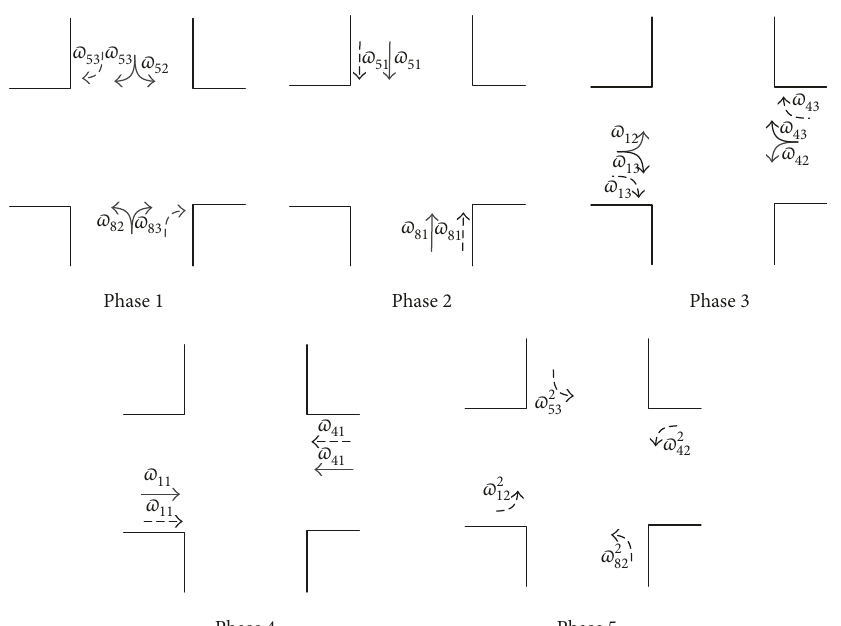
Figure 5: Illustration of control strategy 1 in intersection 2.